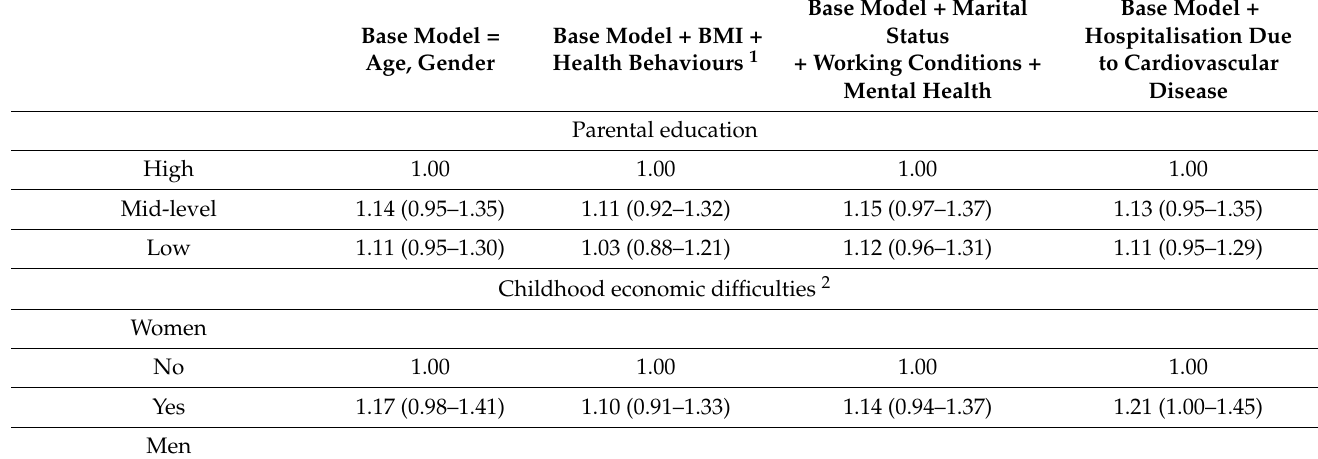
Table 2. The associations between socioeconomic circumstances and hypertension medication. Odds ratios and 95% confidence